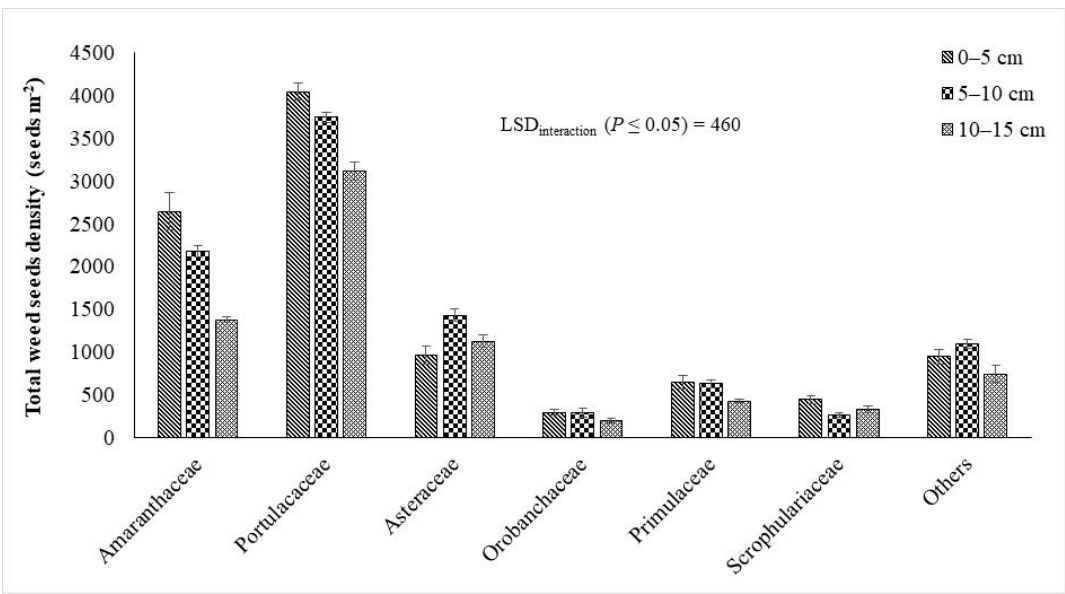
Figure 3. Total weed seedbank density (seed m − 2 ) as affected by the ‘botanical family × soil layer depth’ interaction.